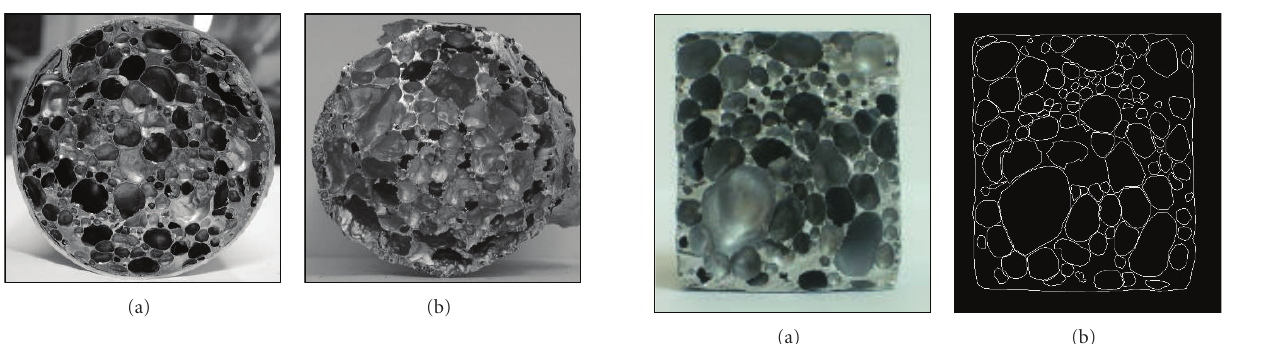
Figure 14: Di ff erent foaming gas (SM, ambient, ∅ 64): (a) nitrogen and (b) air.